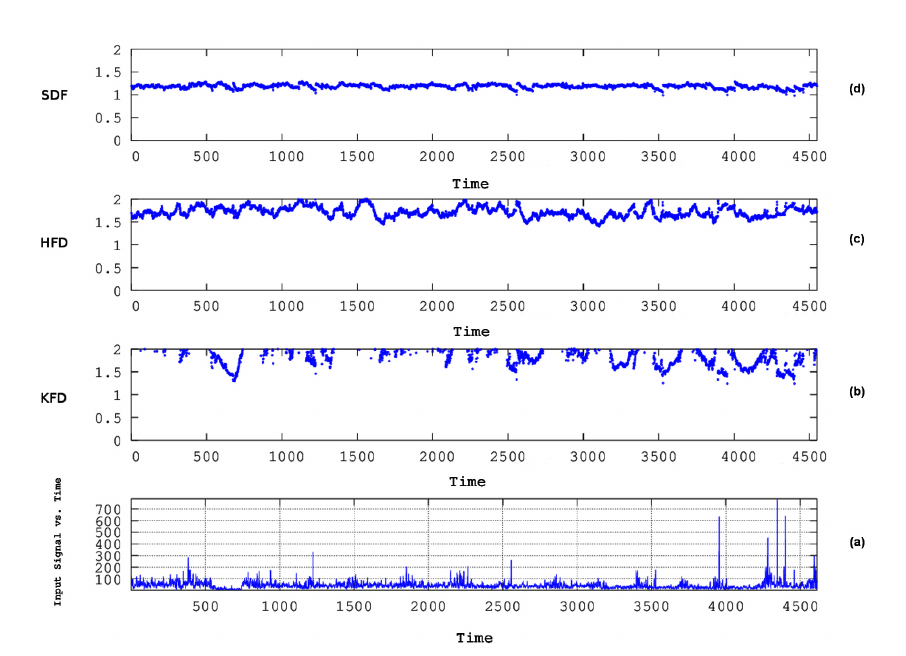
Figure 4. Time evolution of the fractal dimension of the PM 10 time series recorded by the MAR station between the years 2001–2016. From bottom to top: ( a ) time series (mean daily values/concentrations) and fractal dimensions according to the algorithms of ( b ) KFD ( c ) HFD, and ( d ) SFD. PM 10 concentration in µ g/m 3 . Time is in days (or sample number). Each window of analysis contains 64 samples.